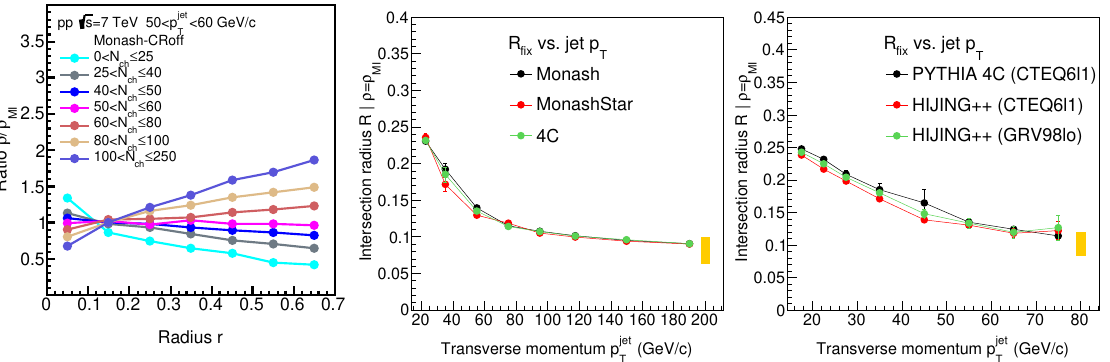
Figure 2. ( Left ) The differential jet structure compared for many different mutiplicity bins. ( Center ) The p jet dependence of R fix for three different P YTHIA tunes. ( Right ) Comparing the p jet T R fix from H IJING ++ to that of P YTHIA using two different PDF sets.